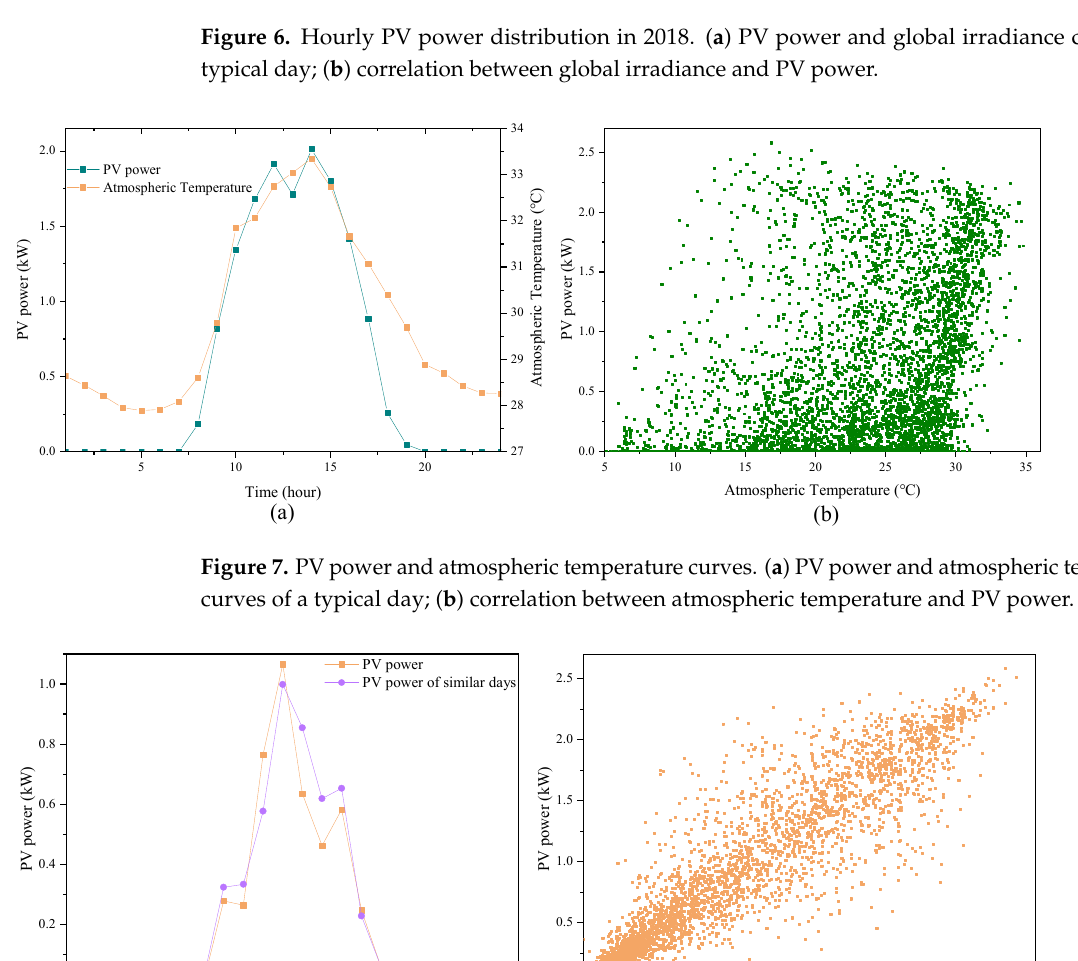
Figure 6. Hourly PV power distribution in 2018. ( a ) PV power and global irradiance curves of a typical day; ( b ) correlation between global irradiance and PV power.